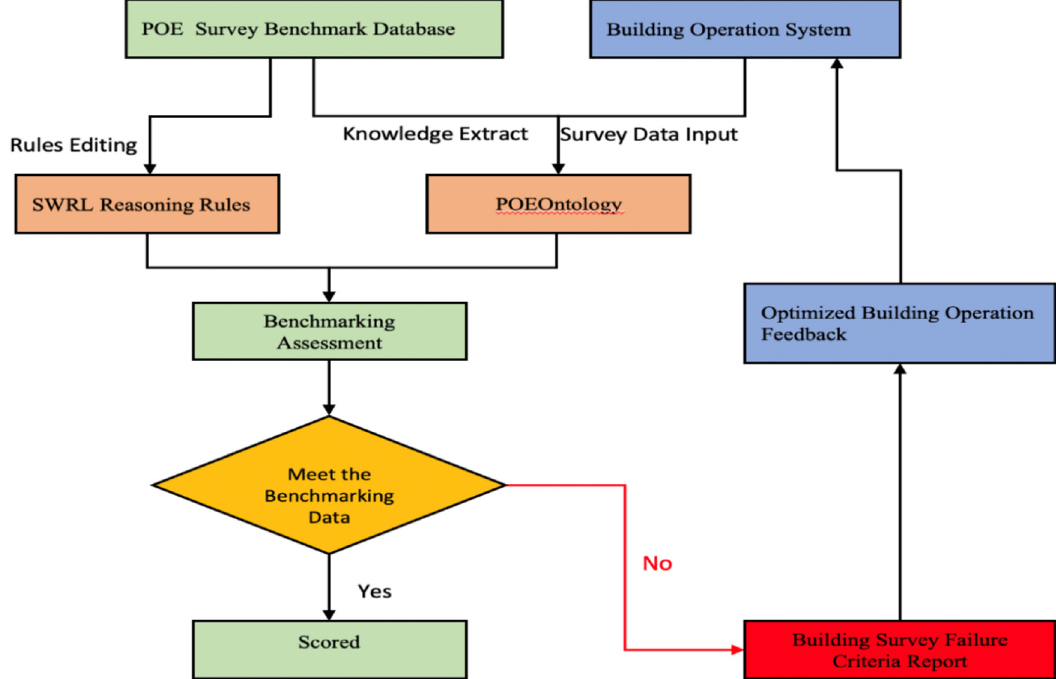
Fig. 1. The framework of comprehensive post occupancy building performance